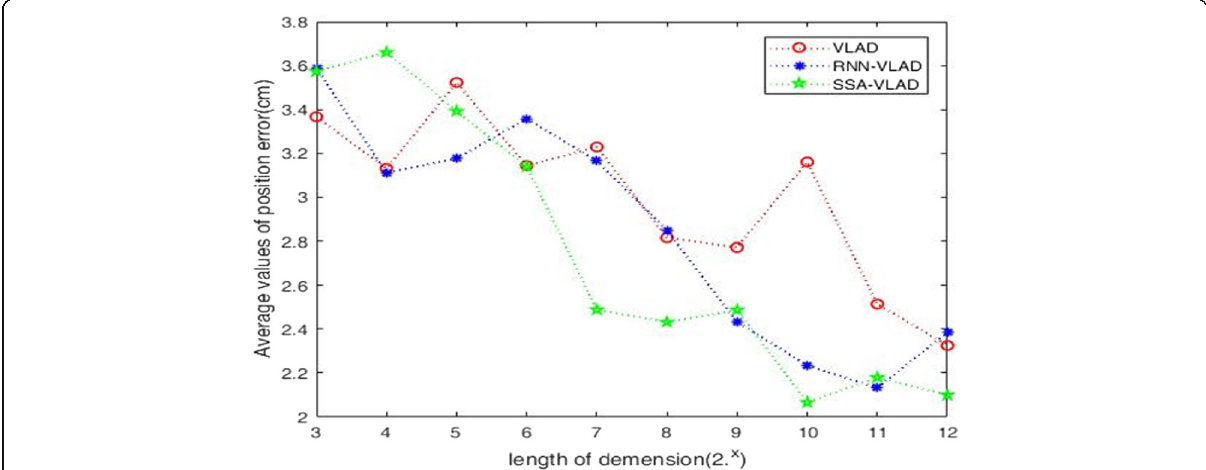
Fig. 2 The average values of position error with different lengths of dimension legend: The x -axis denotes the dimension length, and the y -axis denotes the average values of position error